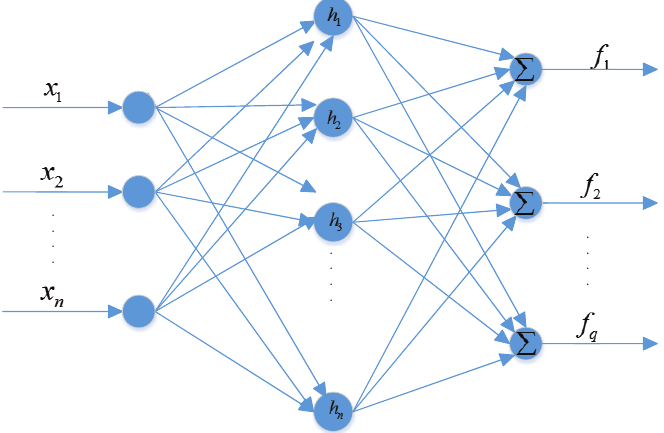
Figure 1. The structure of a neural networks (NN).